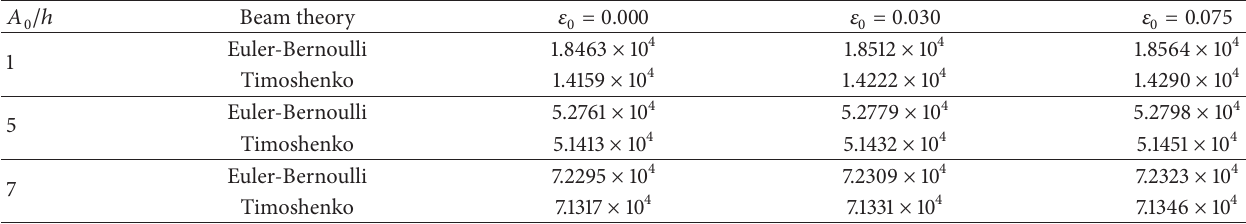
Table 5: The nonlinear natural frequency for different values of 𝜀 0 with various 𝐴 0 /ℎ ( 𝐿/ℎ = 6 , 𝑇 = 60 ∘ C, and 𝑉 𝑠 = 0.005). 𝐴 /ℎ 0